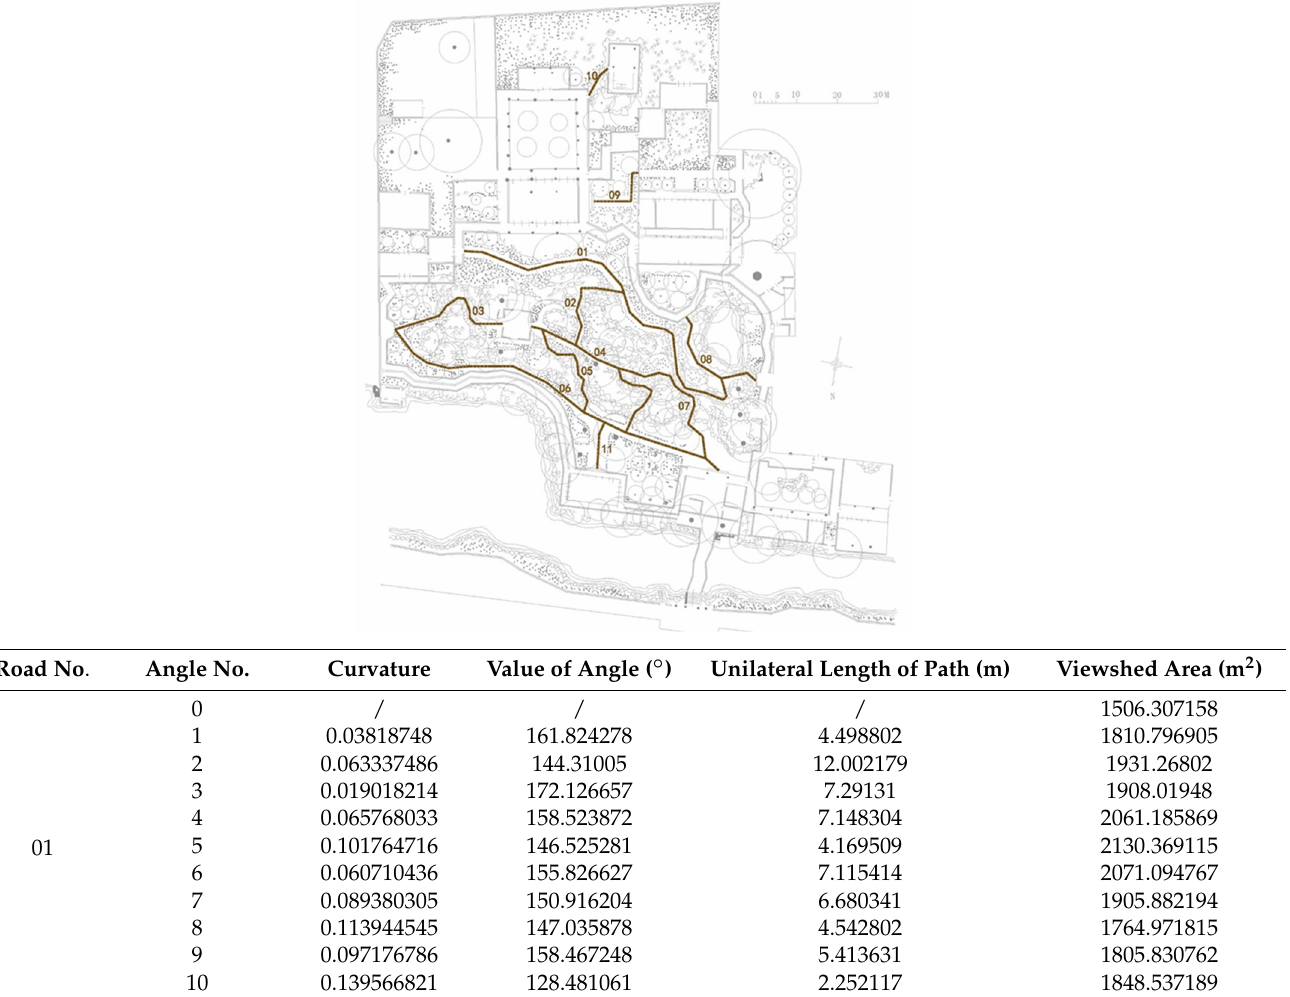
Table A4. Canglang Pavilion, garden path.